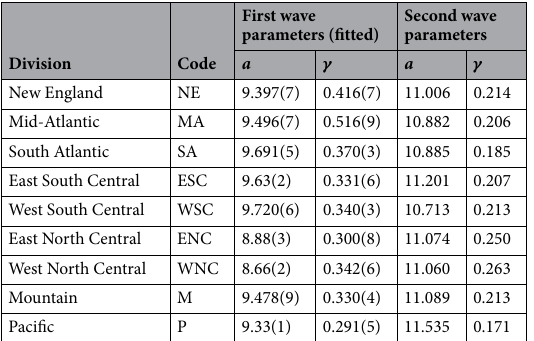
Table 3. Parameters of the eRG model for the first and second wave in the 9 divisions. For the first wave, we report the values from the fit, including the 1 σ error. For the second wave, the values are chosen to reproduce the current data, adjourned to December